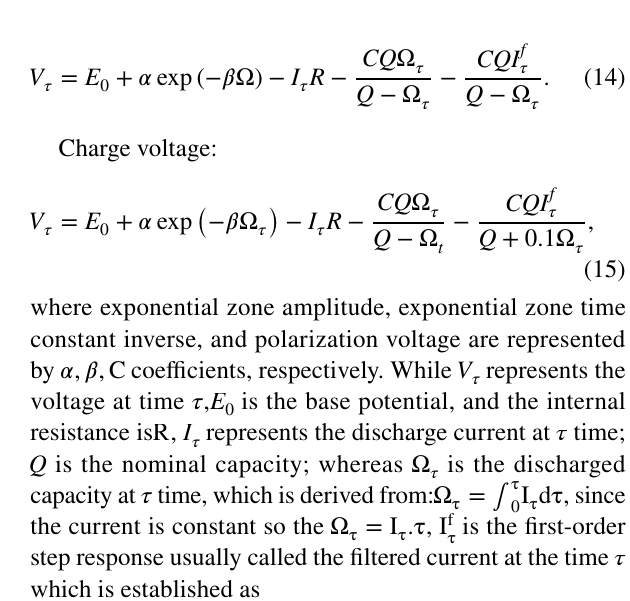
Bold values best results among the compared optimizers are